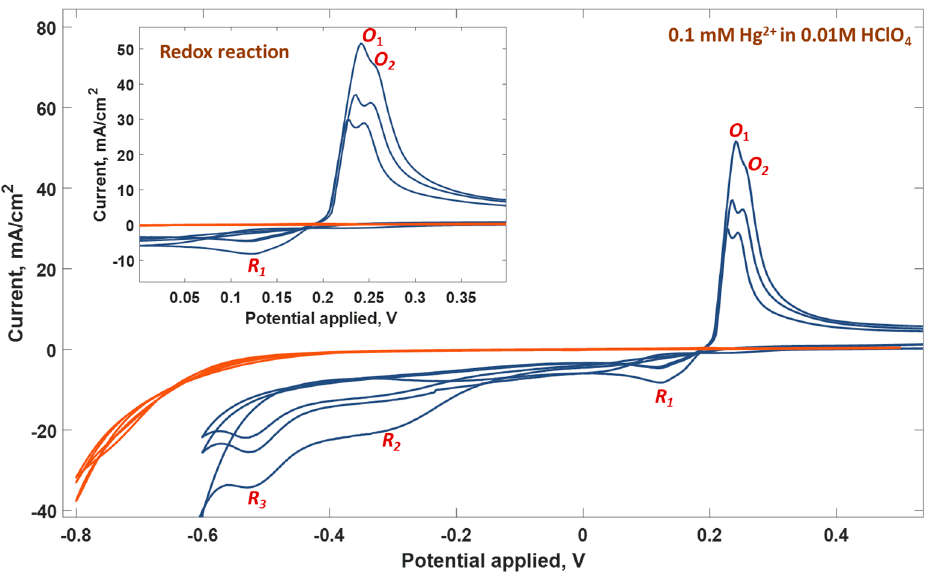
Figure 1. Cyclic voltammogram of the epitaxial graphene working electrode in the 0.01 M HClO 4 electrolyte solution without (deep orange colored curves correspond to three consequent cycles) and (dark blue colored curves correspond to three consequent cycles) with 0.1 mM Hg 2+ ; scan rate: 20 mV·s − 1 . Inset: zoomed region of the cyclic voltammogram, which represents the cathodic and anodic processes in the potential range from 0 to 0.4 V.